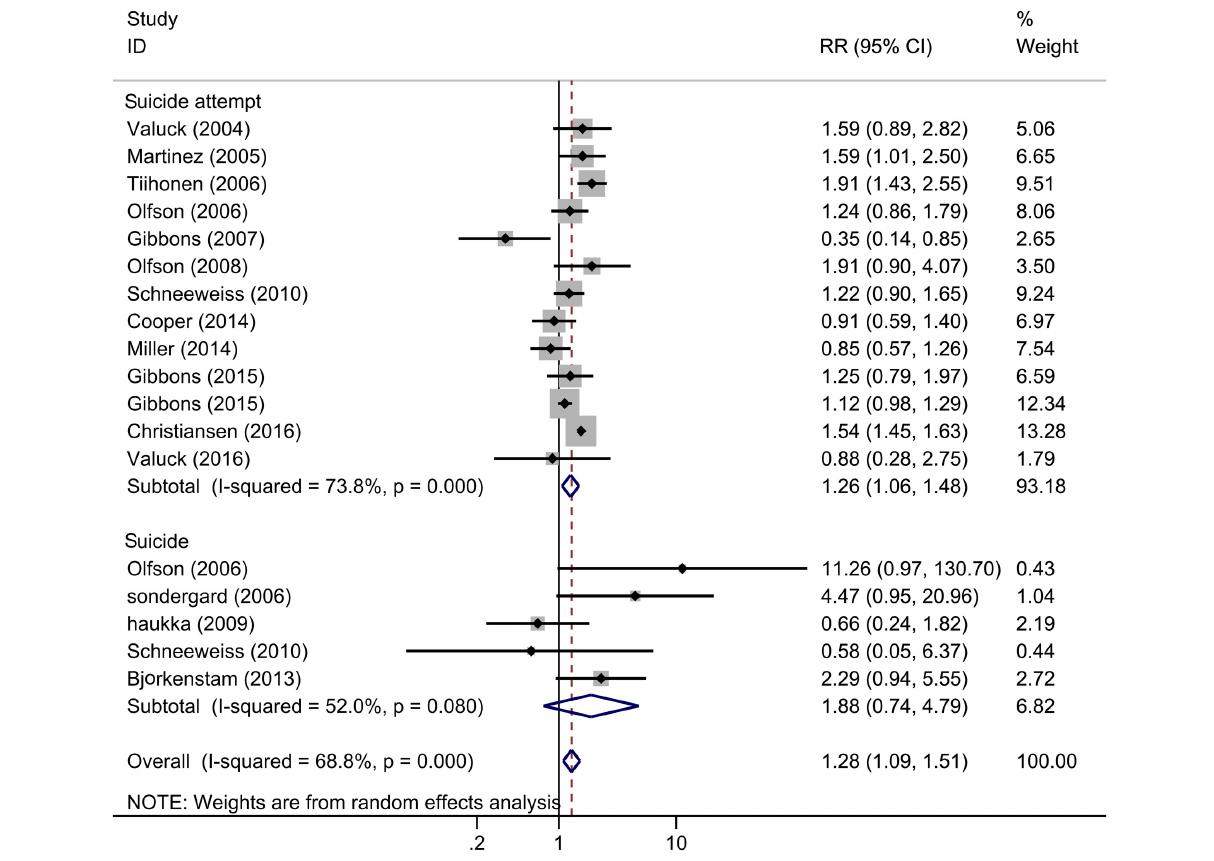
FIGURE 3 | Forest plot of selective serotonin reuptake inhibitor (SSRI) exposure and the risk of suicidal behavior among children and